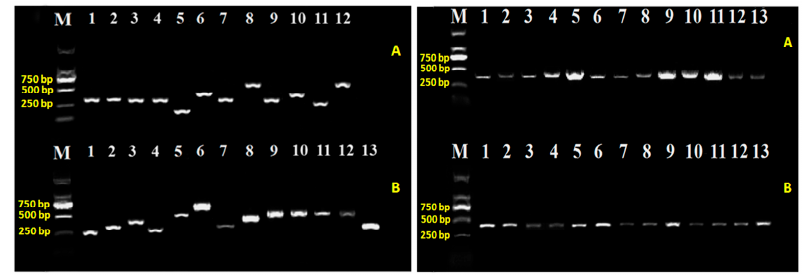
Figure 2. Validation of the 25 T6SS using specific primers of each gene (left) and specific primer of Acidovorax avenae subsp. avenae strain RS-2 mutants (right); M: Marker DL2000; ( A ) 1~13: Δ pppA , Δ clpB , Δ hcp , Δ fHA , Δ lip , Δ impJ , Δ dotU , Δ icmF , Δ impM , Δ impA , Δ impB , Δ impC , the w ild-type; ( B ) 1~13: Δ impE , Δ impF , Δ dUF879 , Δ impH , Δ clpV , Δ vgrG-1 , Δ vgrG-2 , Δ vgrG-3 , Δ vgrG-4 , Δ vgrG-5 , Δ vgrG-6 , Δ vgrG-7 , Δ vgrG-8.